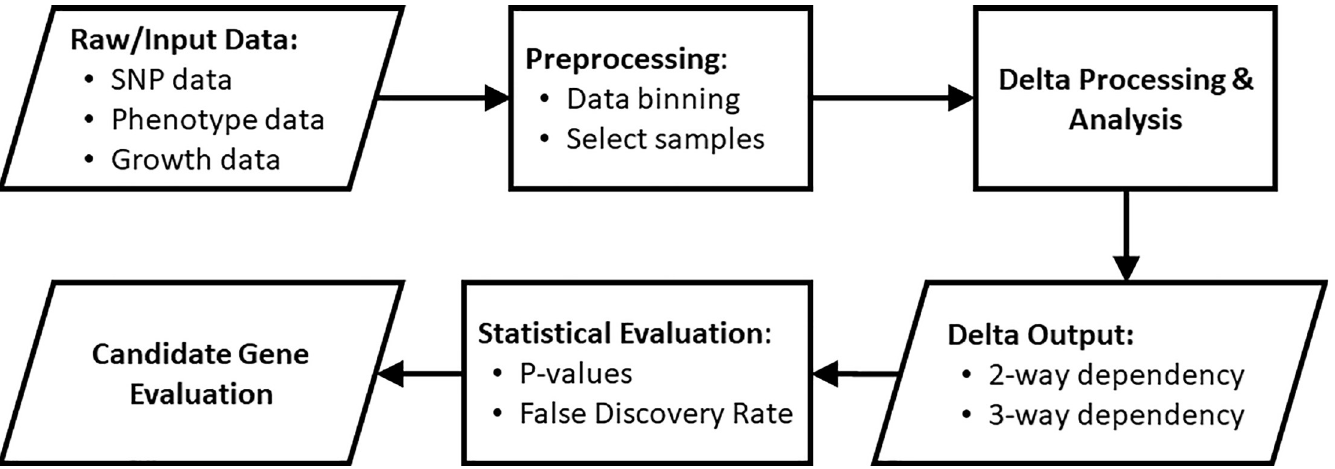
Fig 10. Flow chart of the process of selecting gene candidates using our dependency measures. The measures of multi-variable dependencies and Delta are described in Section 4.1.3, and the preprocessing of phenotypes and SNP data are described in Section 4.2. The statistical evaluation is explained in Section 4.3.